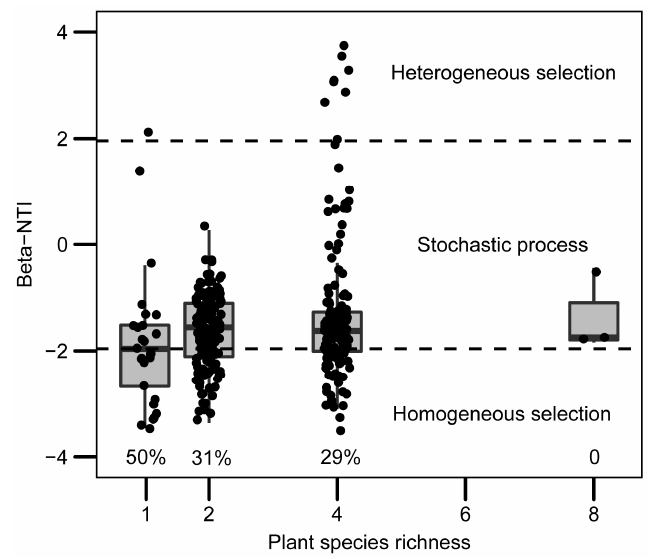
Figure 4. Distribution of beta-NTI values along native plant species richness gradient. Dash lines at beta-NTI = − 1.96 and beta-NTI = 1.96 denote thresholds for the assembly process. The percentage below the box plot represents the proportion of homogenous selection.